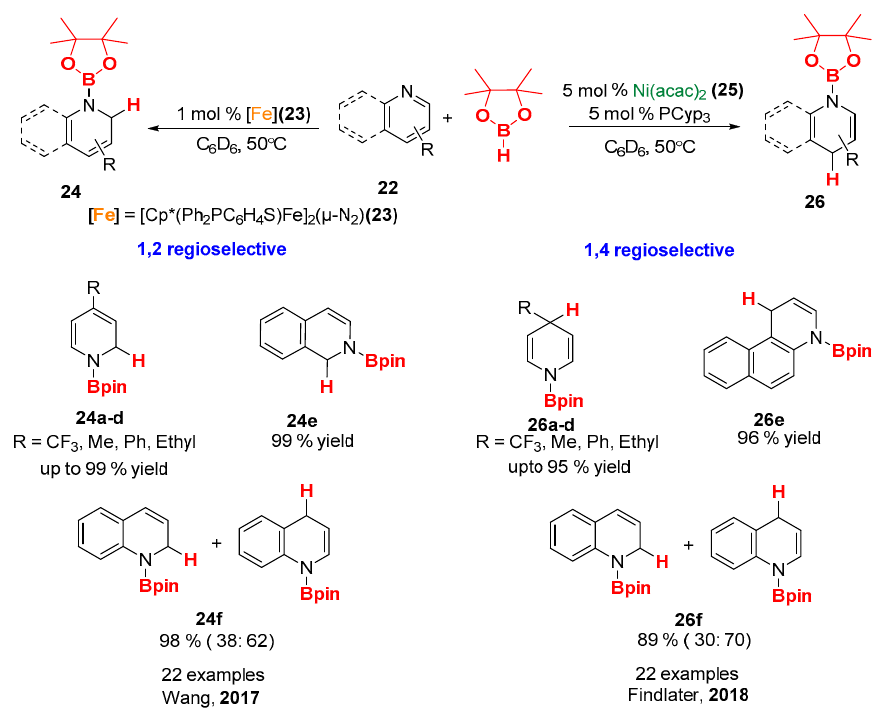
Scheme 4. Comparison of [Fe] and [Ni] in regioselective hydroboration of N